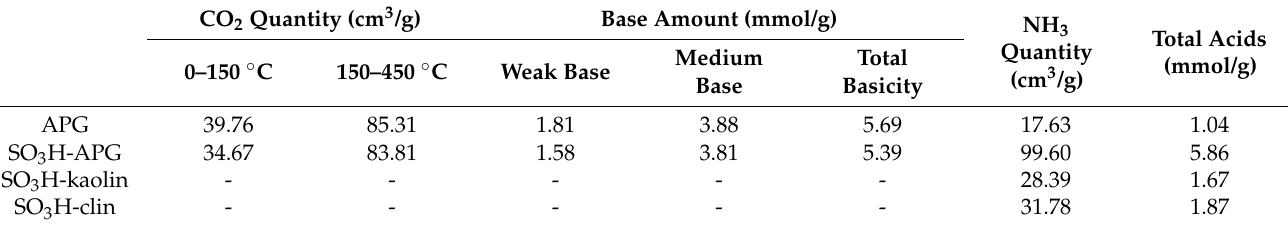
Figure 2. The ( a ) FT-IR, ( b ) N 2 adsorption–desorption isotherms, ( c ) CO 2 -TPD, and ( d ) NH 3 -TPD spectra of clay-based catalysts. Table 1. Physiochemical properties of catalysts.